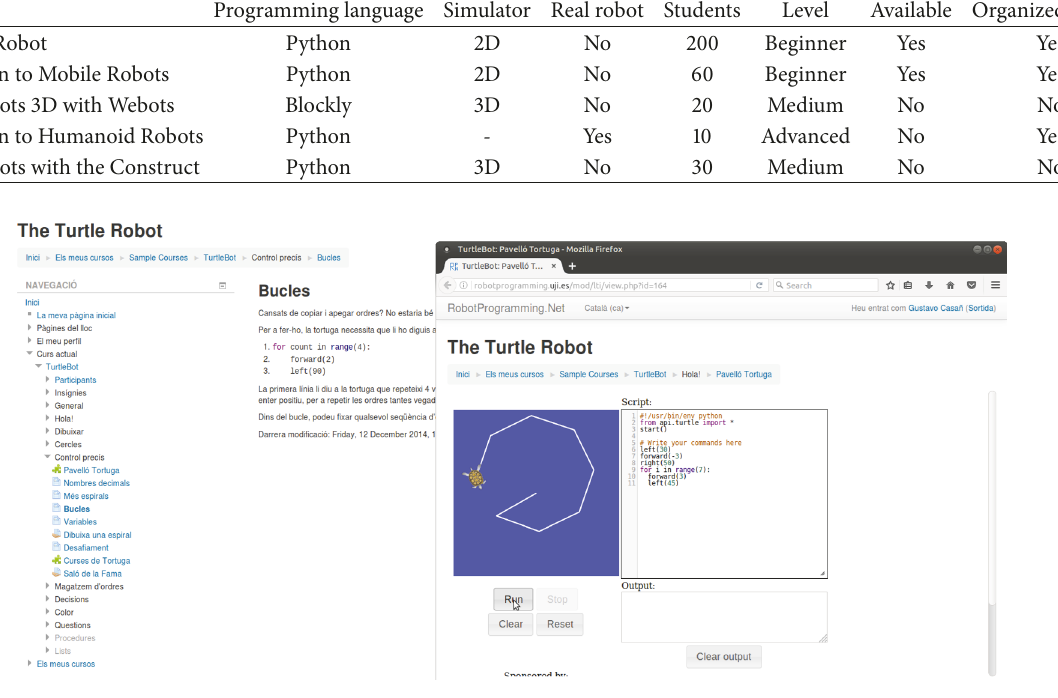
Figure 7: Course documentation page of the course (left) and programming page